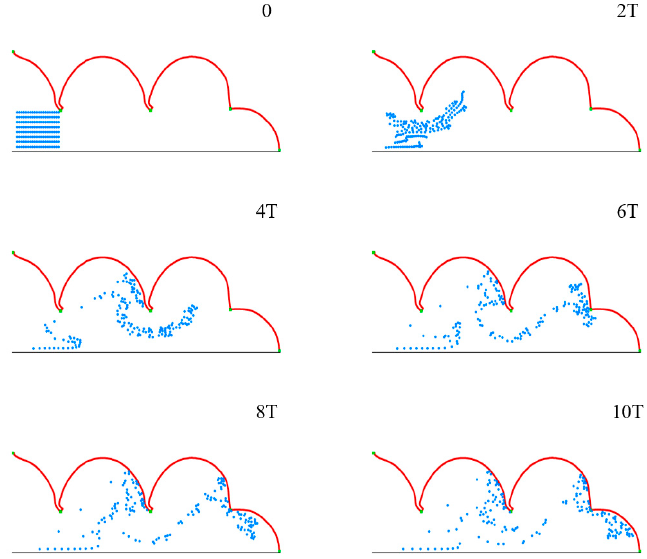
Figure 7. The movement and distribution of microparticles in pulmonary acini during the respiratory